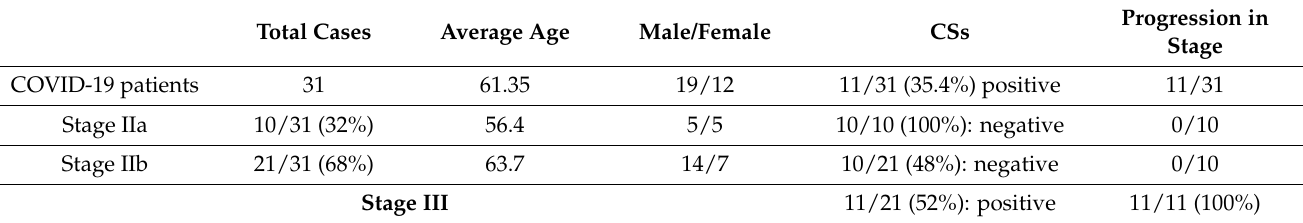
Table 2. Retrospective analysis of patients admitted to Infectious Disease wards with confirmed severe acute respiratory syndrome coronavirus 2 (SARS-CoV-2) infection.